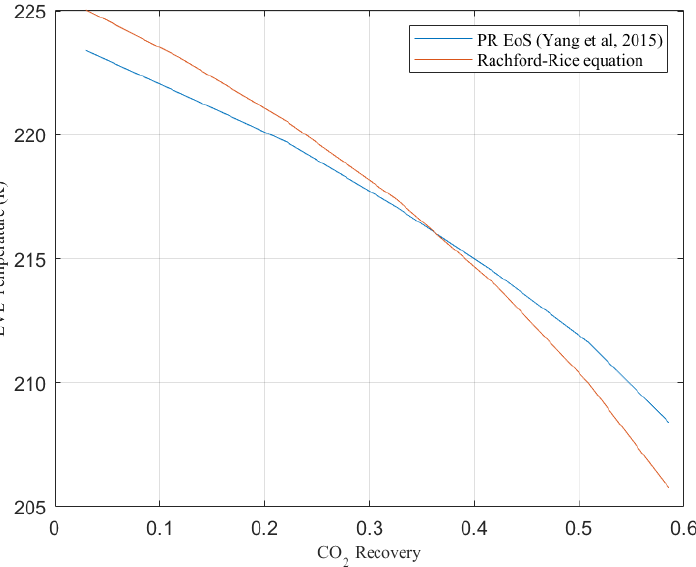
Figure 7. Comparing the calculated LVE temperature using the Rachford–Rice model with the literature [53].